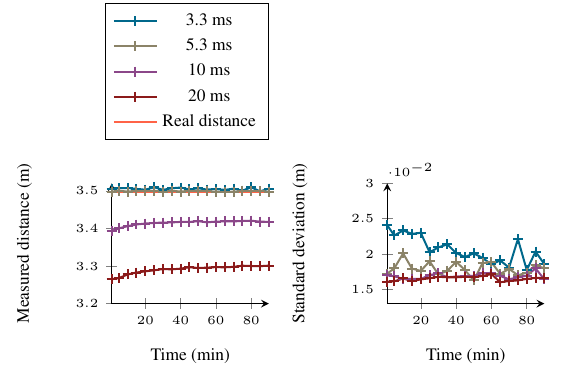
Figure 4. Standard deviation (m) of 50 acquisitions (sight dis- tance of 2 m, integration time of 3.3 ms)